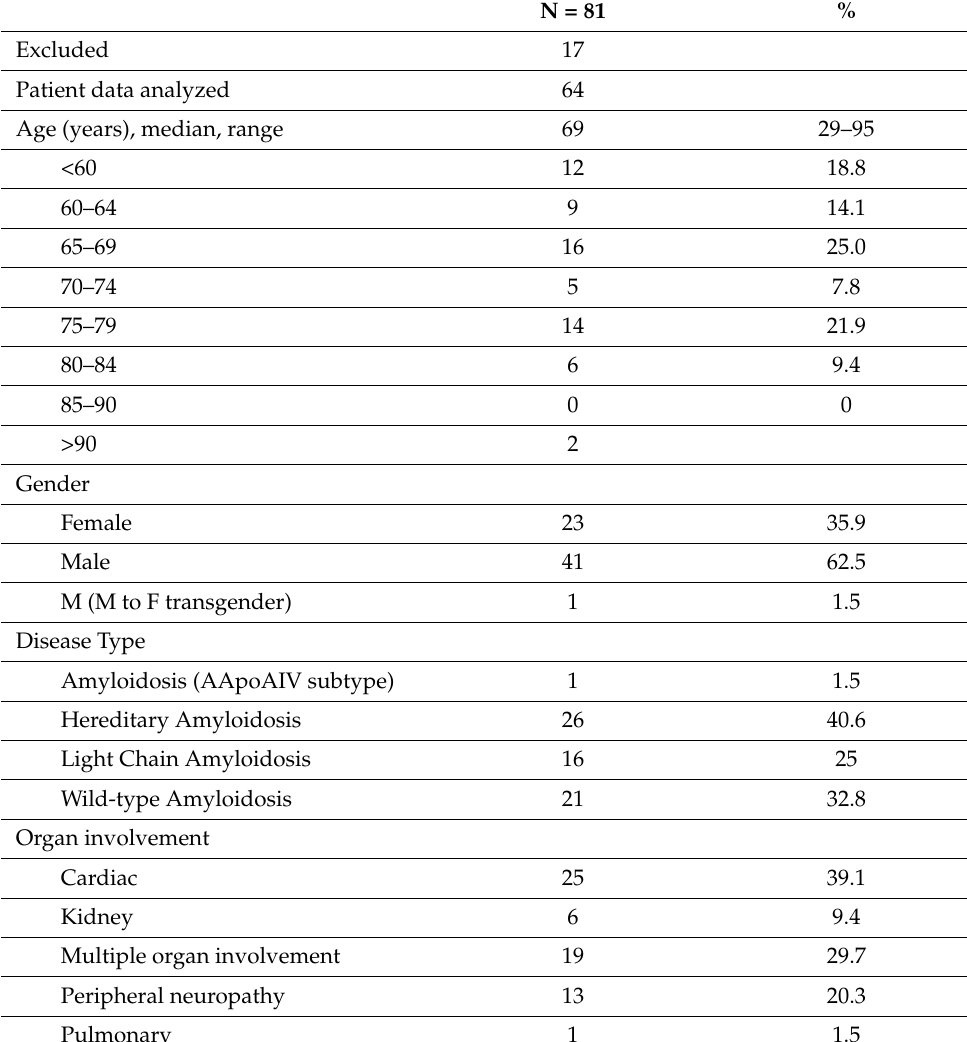
Table 1. Patient